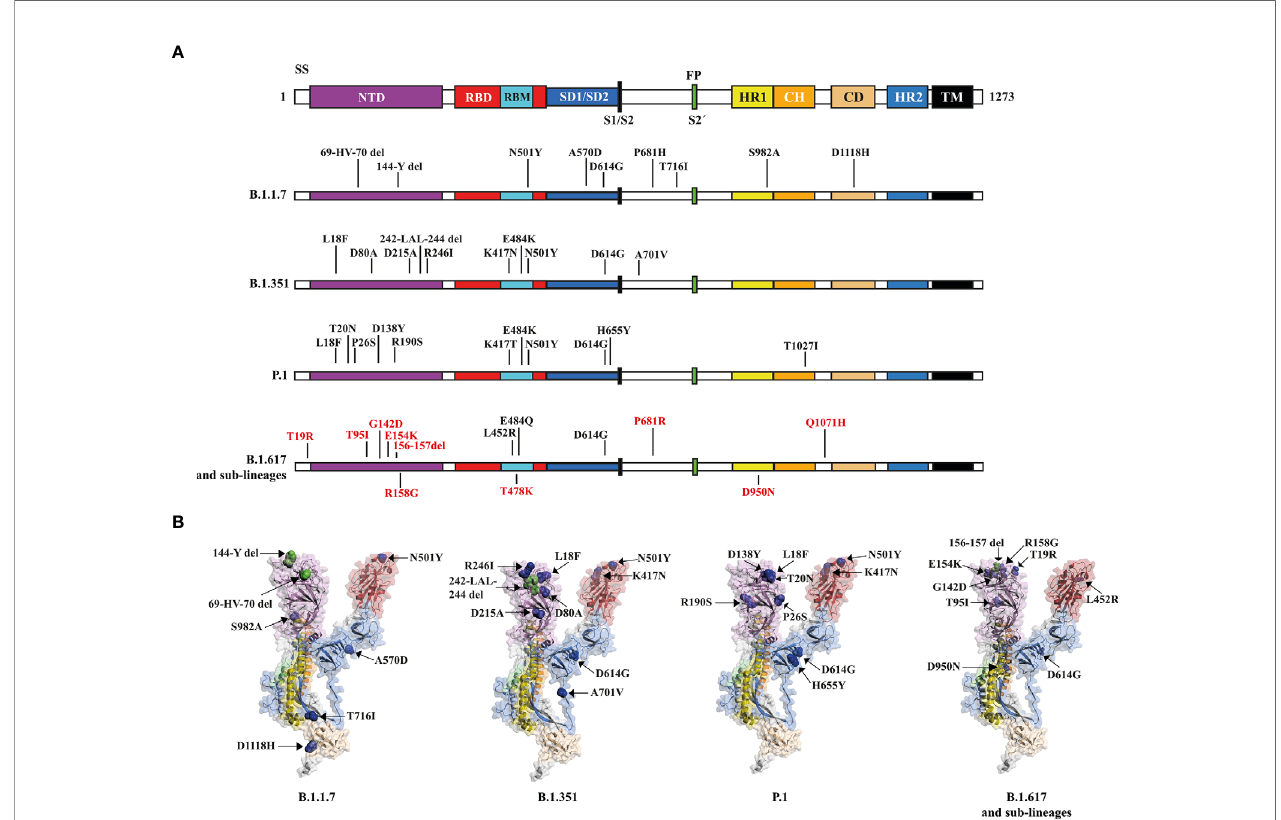
FIGURE 4 | Structural mutations of the S glycoprotein in the SARS-CoV-2 variants: B.1.1.7., B.1.351, P.1, B.1.617 and his sub-lineages. (A) Schematic representation of the S glycoprotein (PDB:7DK3) and the changes present in variants. The amino acid mutations for the sub-lineages of B.1.617 are shown in red. (B) Structural representation of the S glycoprotein, showing deletion sites (del) (green dots) and mutation sites (blue dots) for each of the panel (A) variants. Some mutations are not shown because they are in unresolved